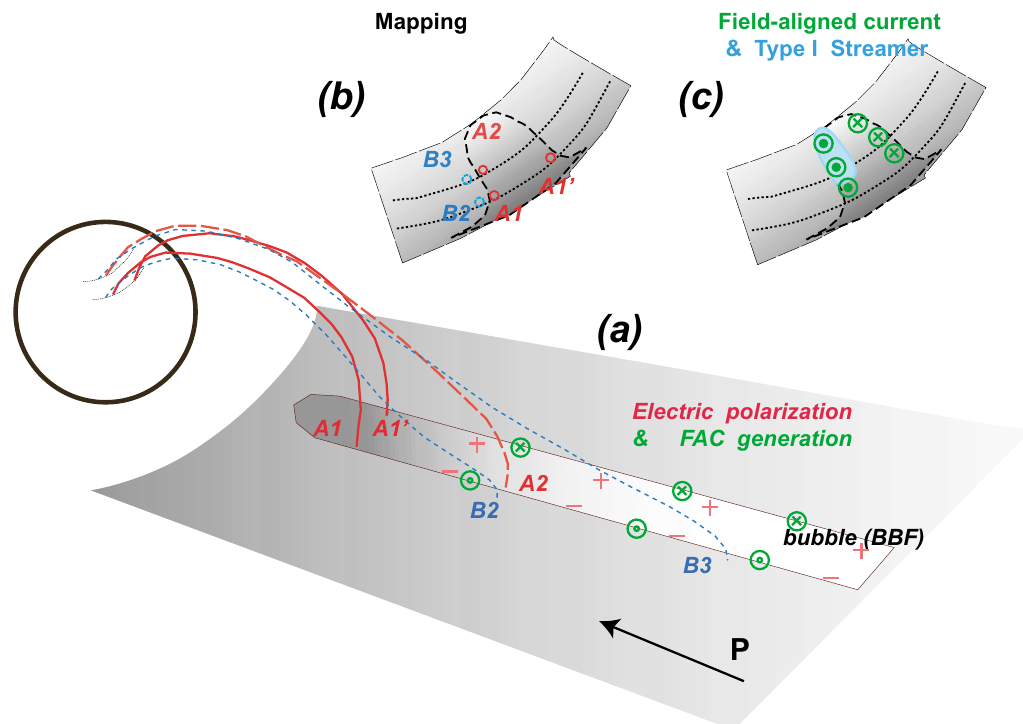
Fig. 6. Scheme showing the ionospheric mapping and manifestations of the narrow bursty bulk flow as predicted by the plasma bubble